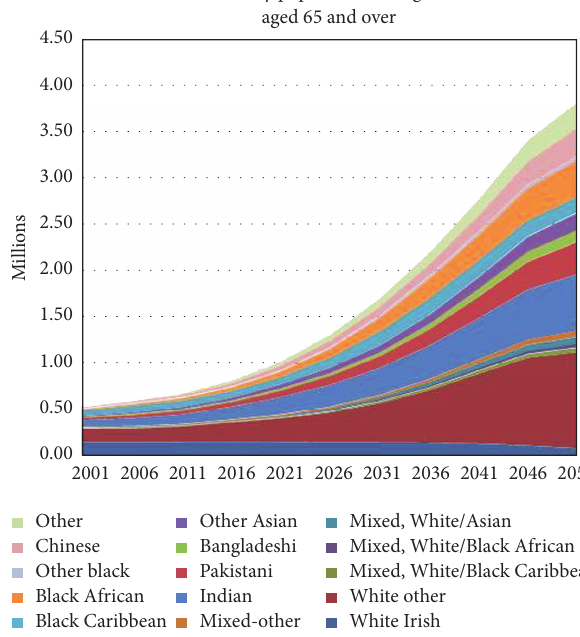
Figure 1: Ethnic minority population projections to 2051, England and Wales from Lievesly, 2010 [4].